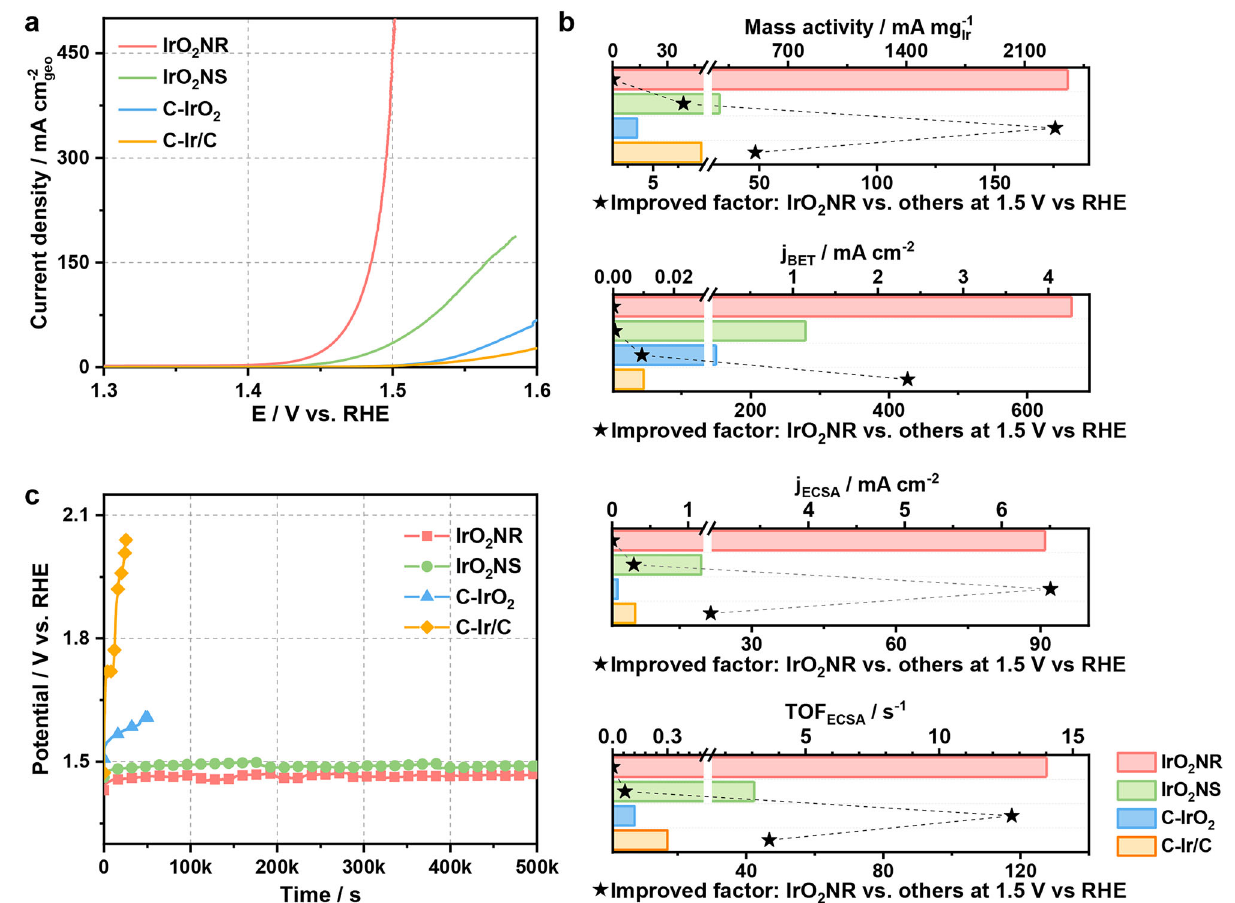
Fig. 3 | The OER activities of the IrO 2 NR, IrO 2 NS, C-IrO 2 and C-Ir/C in 0.5M H 2 SO 4 . a LSV curves of the IrO 2 NR, IrO 2 NS, C-IrO 2 and C-Ir/C samples. b Mass activitiesand speci fi cactivitiesbasedontheBETareasand ECSAareas determined by the mercury underpotential deposition method and TOF values based on the